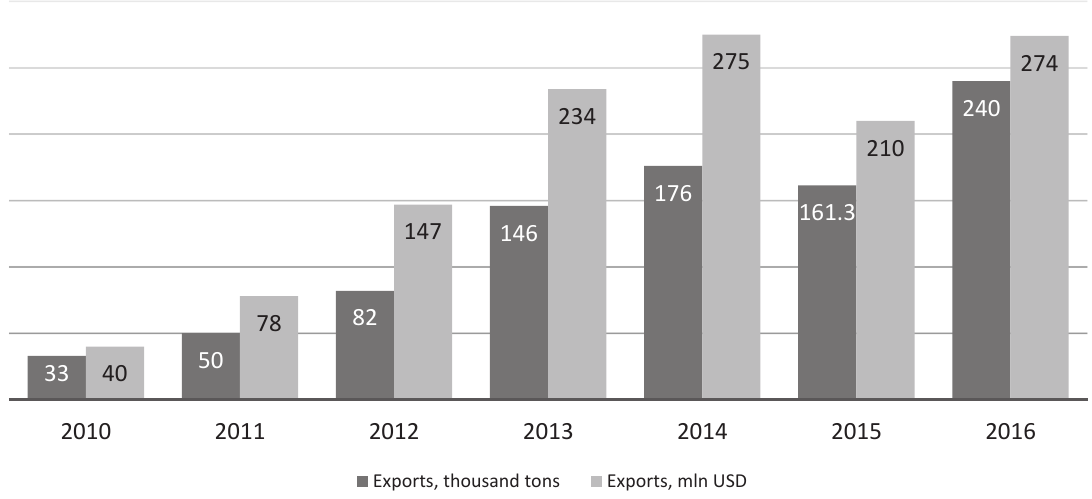
Figure 5. The volume of poultry export in